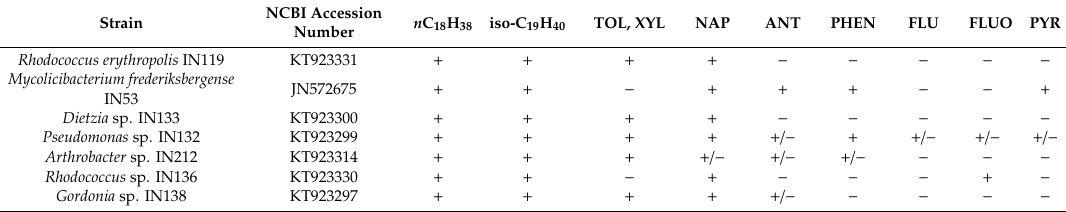
Table 6. Hydrocarbon-degrading capabilities of bacterial strains comprising the mixed culture C2. Strain NCBI Accession